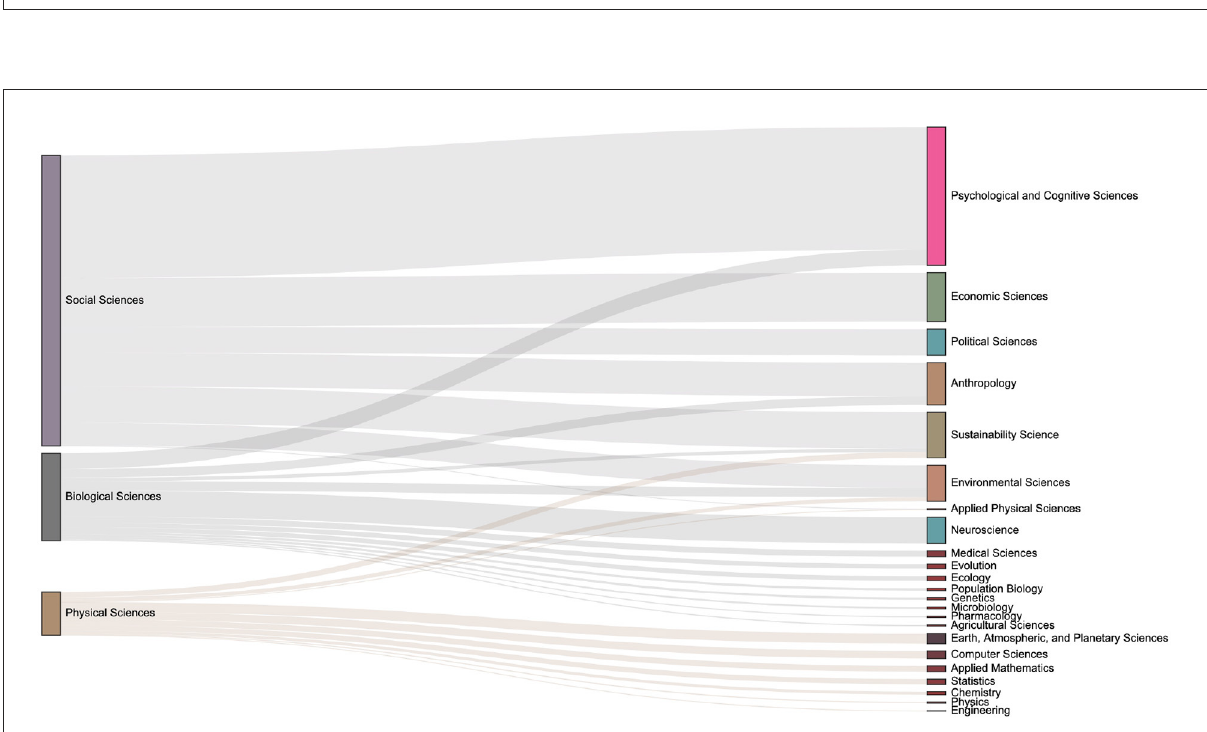
FIGURE13 The distribution of keyword mention times in various fields in the 2020s. Compared with the previous period, discussions on economic-related issues have increased during this